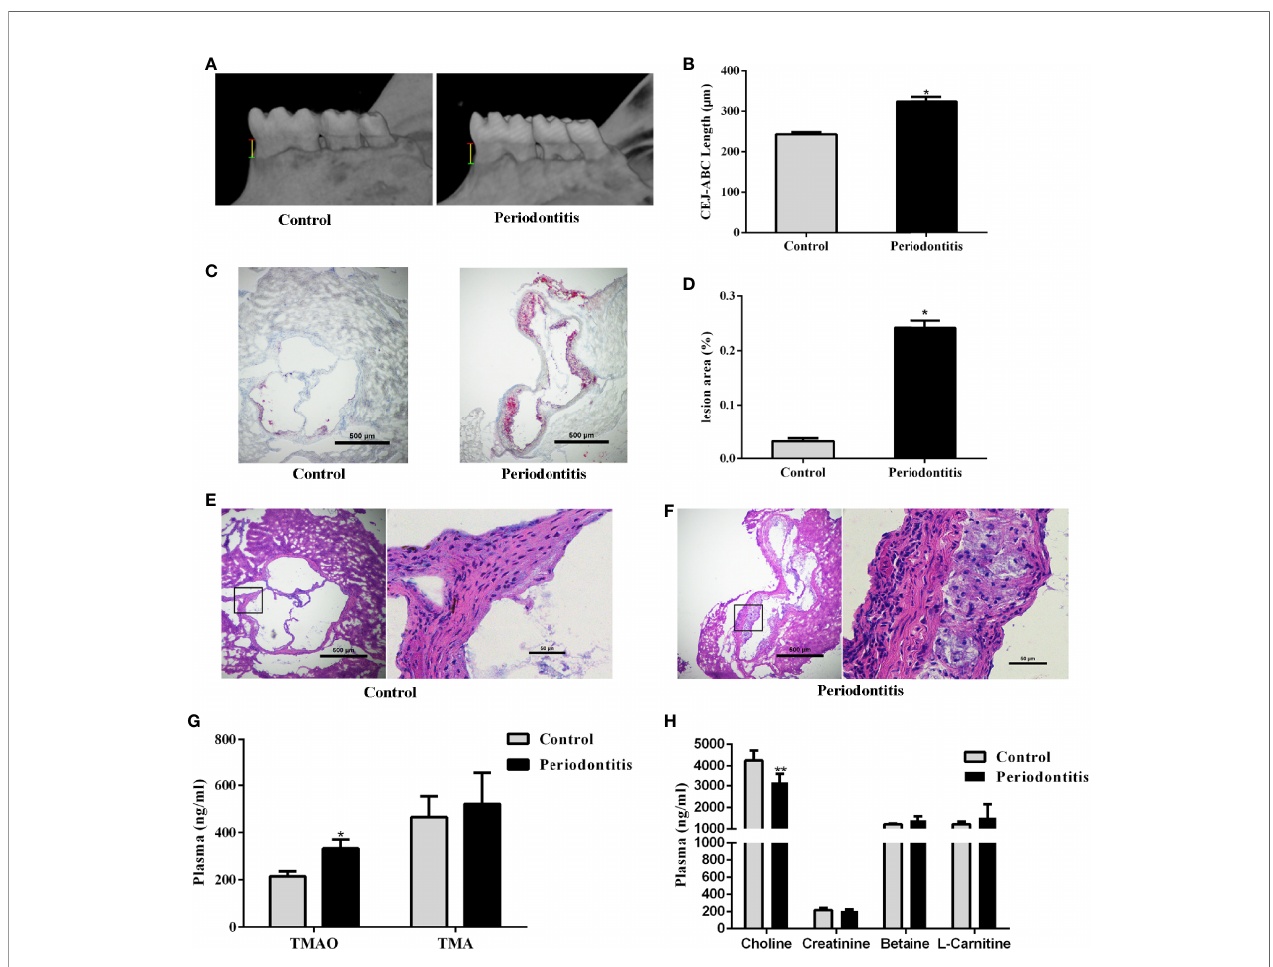
FIGURE 1 | Effect of periodontitis on alveolar bone resorption, morphologic characterization of aortic plaques, plasma TMAO/TMA levels and plasma Choline/ Creatinine/Betaine/L-Carnitine levels. (A) hemi-mandible from each group, as reconstructed by the micro-CT. (B) Cemento-enamel junction (red line: CEJ)-alveolar bone crest (green line: ABC) distance to represent alveolar bone loss (yellow line). (C) Representative Oil-Red-O stained aortic roots from control group and periodontitis group. (D) aortic root lesion area quanti fi ed using Oil-Red-O staining (original magni fi cation of 400×). (E) representative fi elds of aortic root sections in control group stained with Hematoxylin – eosin. (F) representative fi elds of aortic root sections in experimental periodontitis group stained with Hematoxylin – eosin. (G) TMAO and TMA levels in plasma. (H) Choline, Creatinine, Betaine, and L-Carnitine levels in plasma. Data are presented as mean± SEM. (n = 5/group). *P < 0.05; P <